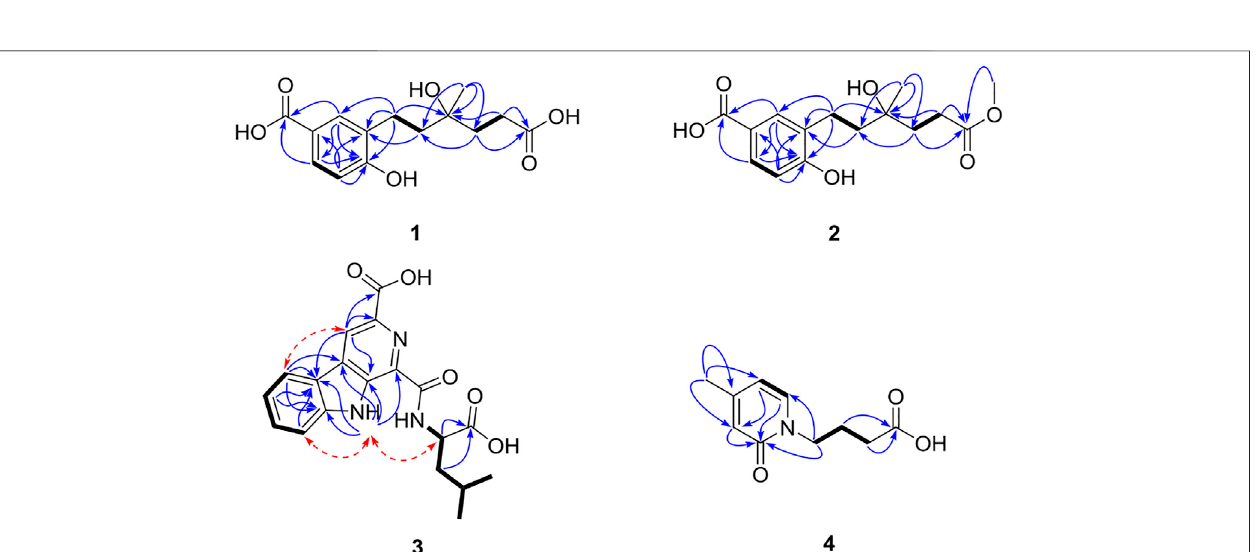
FIGURE 2 | Key HMBC ( → ), 1 H – 1 H COSY ( ▬ ), and ROESY ( ← - → ) correlations of compounds 1 – 4 .